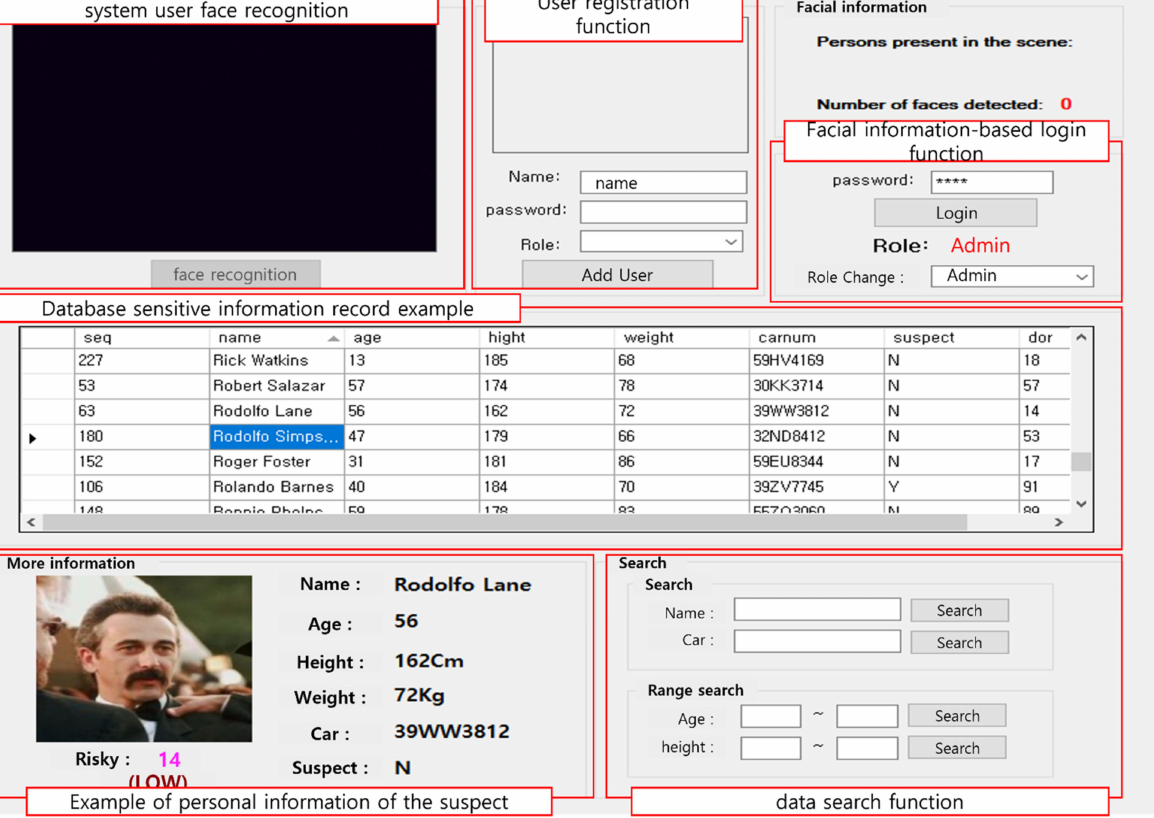
Figure 10. Visualization of the proposed